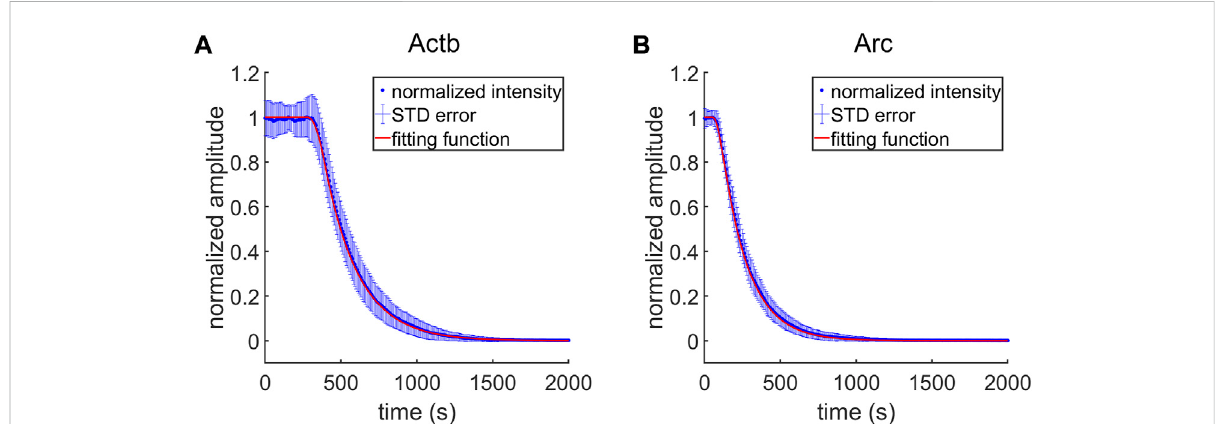
FIGURE 7 Transcriptionintensitiesgeneratedbytime-resolvedcomputer simulation. (A,B) Theaveragesofnormalizedtranscriptionintensitiesareshown asbluedotsforeachcaseofActb (A) andArc (B) transcription (n=100simulationsforeachgene).The errorbar(bluebar)depictsstandarddeviation of the normalized intensities. The fi tting function (red lines) are plotted using the average value of single trace fi tting results.